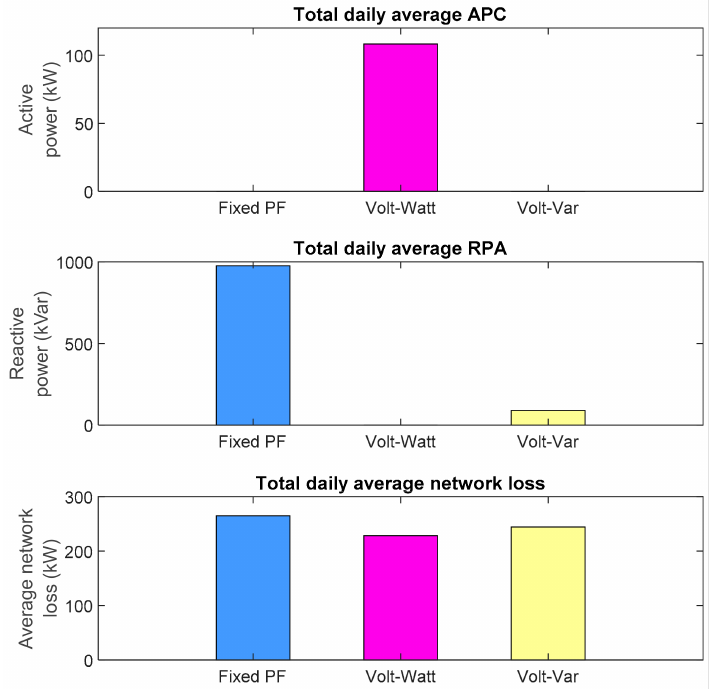
Figure 11. Comparison of simulation